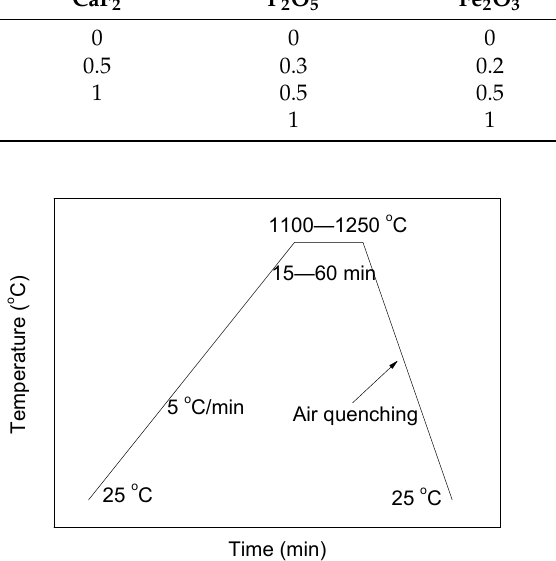
Figure 1. Sintering profiles for the preparation of the TCSA cement clinkers.